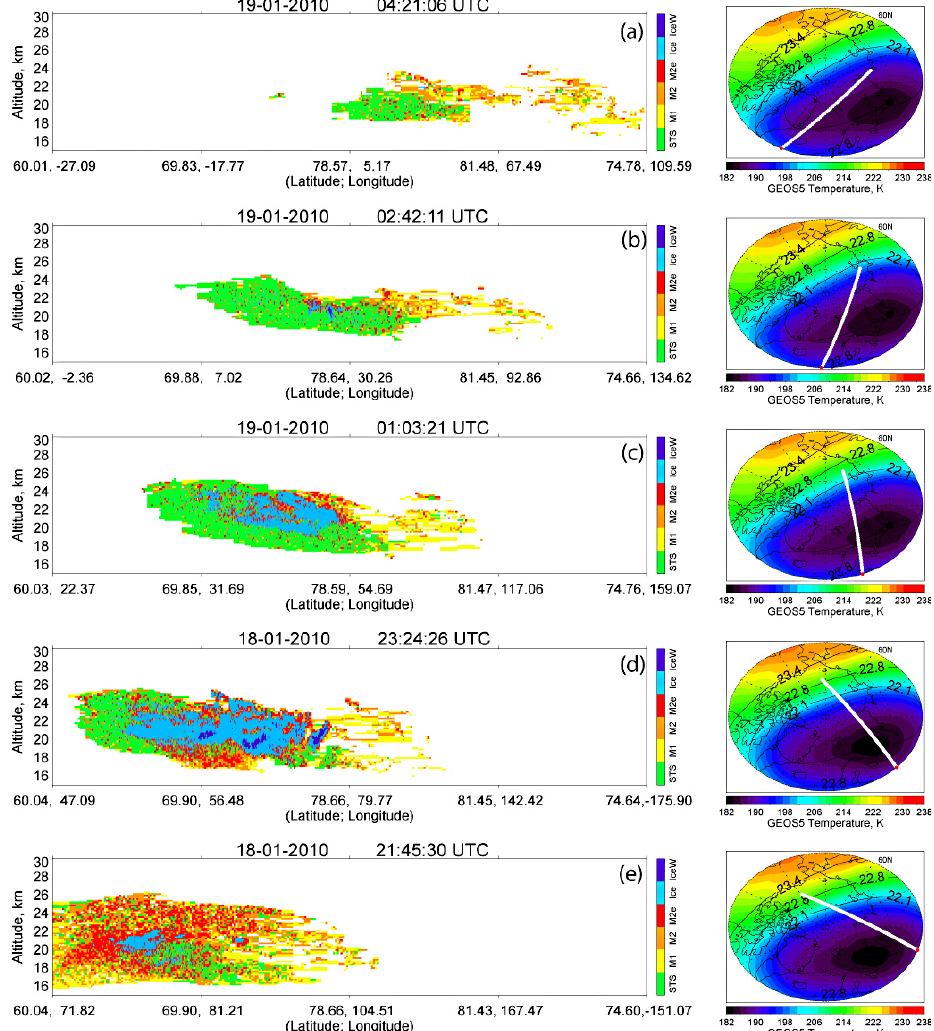
Fig. 15. Examples of CALIPSO PSC observations from five consecutive orbits during 18–19 January 2010. GEOS5 temperature and geopotential height fields at 30hPa for 12:00UTC 18 January are shown on the right with the location of the corresponding CALIPSO orbit tracks indicated by the white